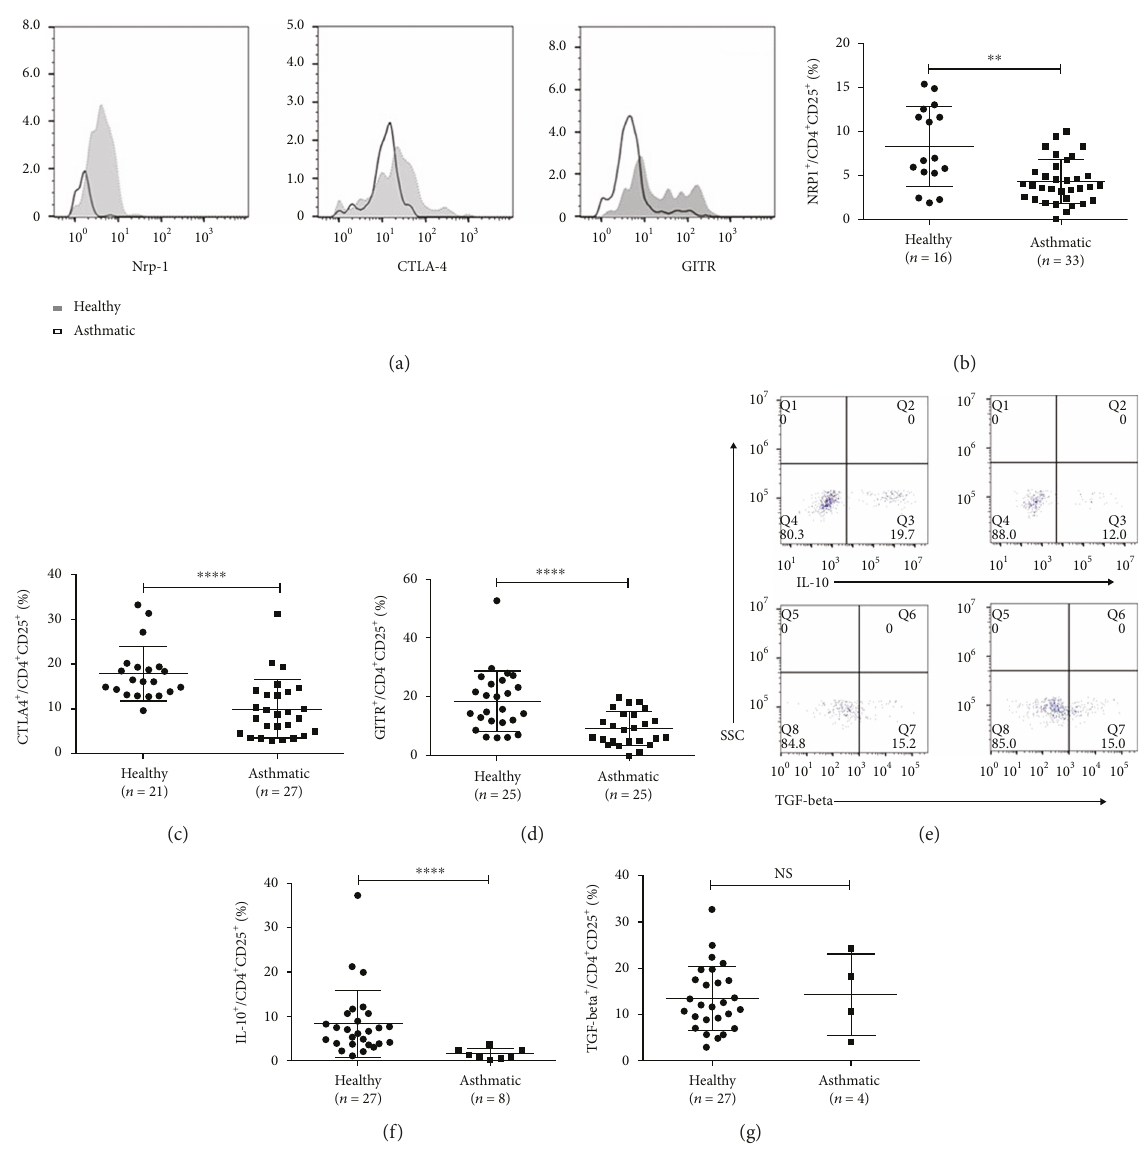
Figure 2: Defective function of Treg cells in immune-suppression. (a) Representative examples of fl ow cytometry analysis of Nrp-1, CTLA-4, and GITR expression by CD4 + CD25 + Treg cells in healthy and asthmatic subjects. (b, c, d) Frequencies of Nrp-1 CTLA-4 and GITR expressed in healthy and asthmatic subjects. (e) Representative examples of fl ow cytometry analysis of IL-10 and TGF-beta production by CD4 + CD25 + Treg cells in healthy and asthmatic subjects. (f, g) Frequencies of IL-10 and TGF-beta production in healthy and asthmatic subjects. The graph shows means ± sem . ∗∗ p < 0 01 and ∗∗∗∗ p < 0 0001 . NS: no signi fi